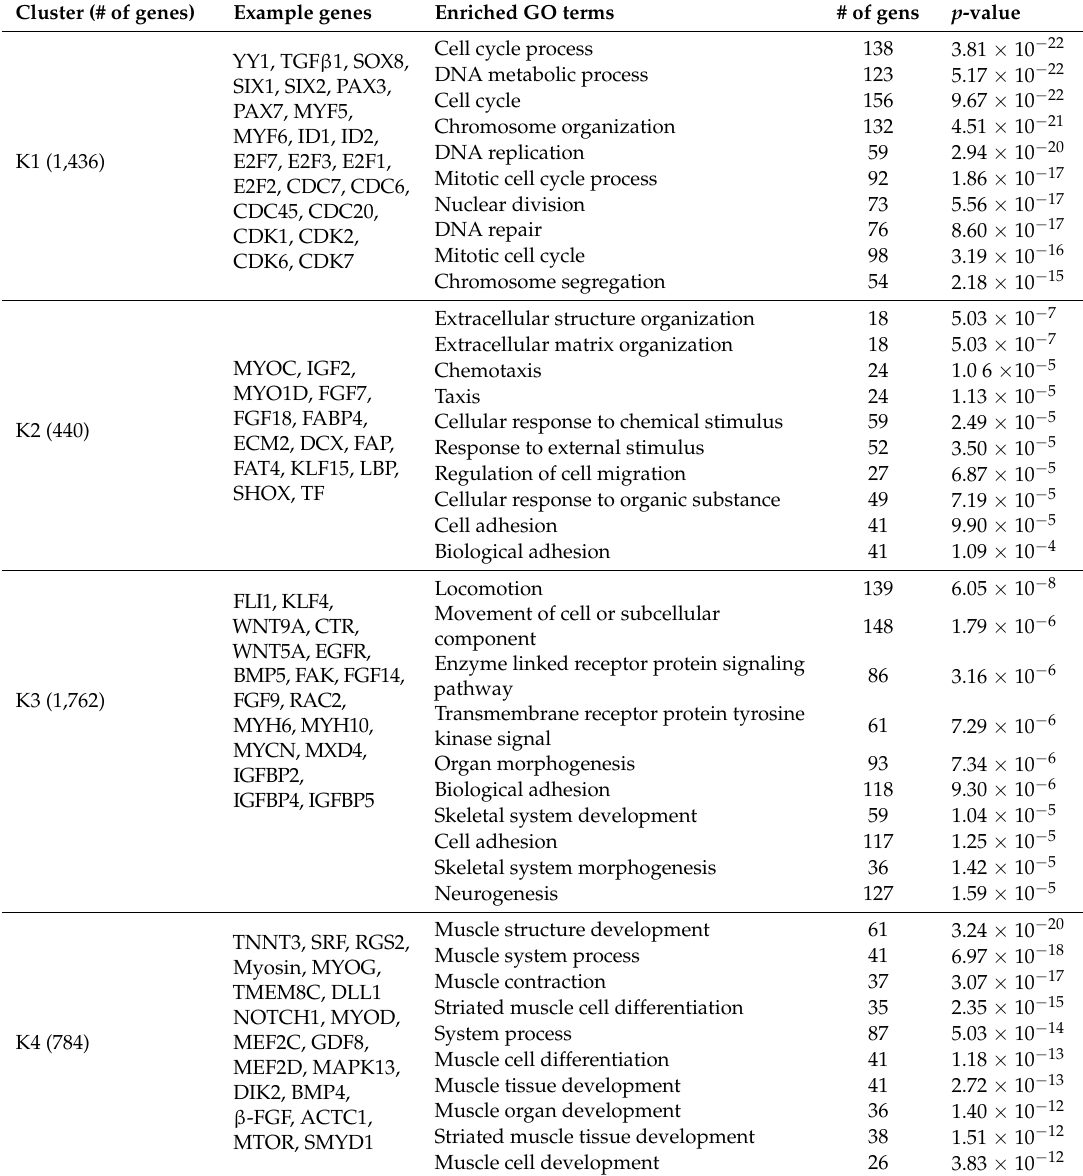
Table 1. Overrepresented GO terms of DEGs involved in different clusters. Cluster (# of